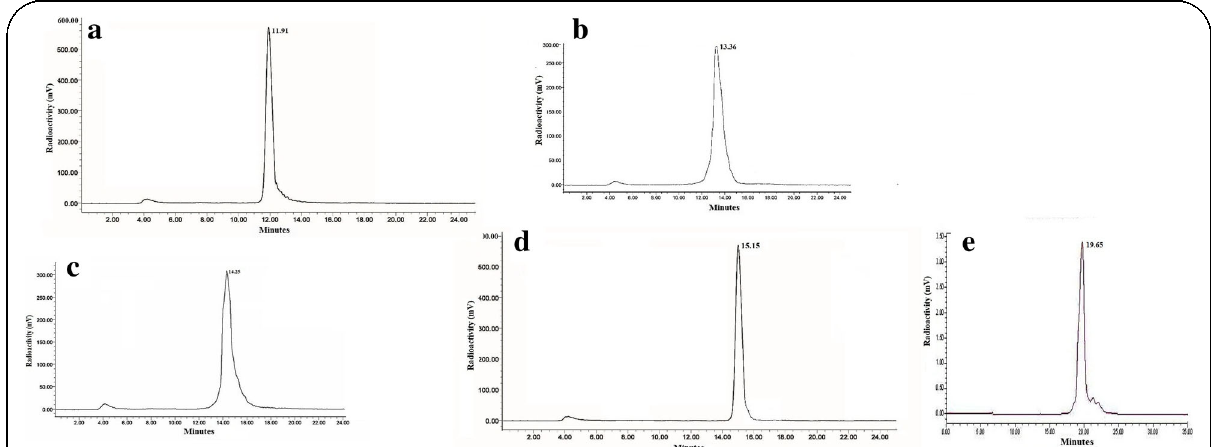
Fig. 3 HPLC profiles of 99mTc-labeled BN analogs [ a : for 99m Tc-BN1; b : for 99m Tc-BN2; c : for 99m Tc-BN3; d : for 99m Tc-BN4; e : for 99m Tc-BNS] used in this study to confirm the radiochemical purities